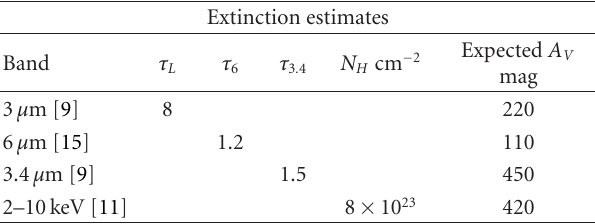
Figure 5: Dust extinction laws obtained by assuming a single power-law form ( f ν ∝ λ Γ ) to reproduce the intrinsic AGN hot-dust emission over the 3–8 μ m band. The solid lines correspond to di ff e- rent choices of the spectral index: blue for Γ = 2, and red for Γ = 3. The dashed lines are standard Galactic extinction curves for comparison: cyan for [18], orange for Chiar and Tielens [28], and green for Nishiyama et al. [29, 30]. The relation with the extinction in visual magnitudes plotted on the vertical axis is based on the latter works, and all the curves are normalized in order to have the same value at 3 μ m. While the exact extinction shape is not so important in the L -band, at 5–8 μ m (and most likely beyond, with the presence of the silicate absorption feature) the di ff erence in terms of optical depth in the di ff erent cases can be as large as a factor of 3. However, it seems quite hard to obtain such a large dust extinction around 6 μ m to be consistent with the gas column density of nearly ∼ 10 24 cm − 2 measured in the X-rays.